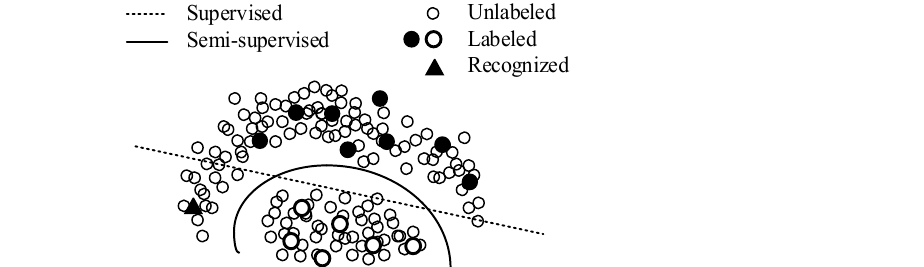
Figure 6. The decision boundary reinforcement by semi-supervised learning. The recognized instance will be class ‘hollow’ in supervised learning. However, the fact is that according to the distribution of the dataset, it should belong to class ‘solid’, which can be achieved in semi-supervised learning.